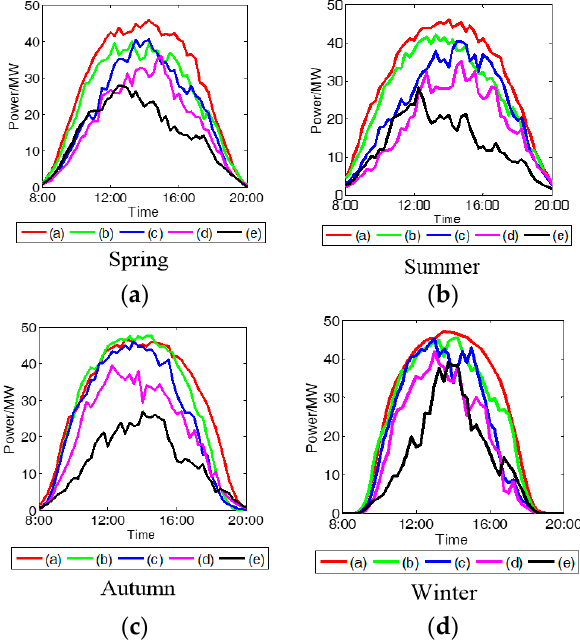
Figure 7. The PV output curves of 5 types of typical days in each season. ( a ) Spring; ( b ) Summer; ( c ) Autumn and ( d ) Winter.